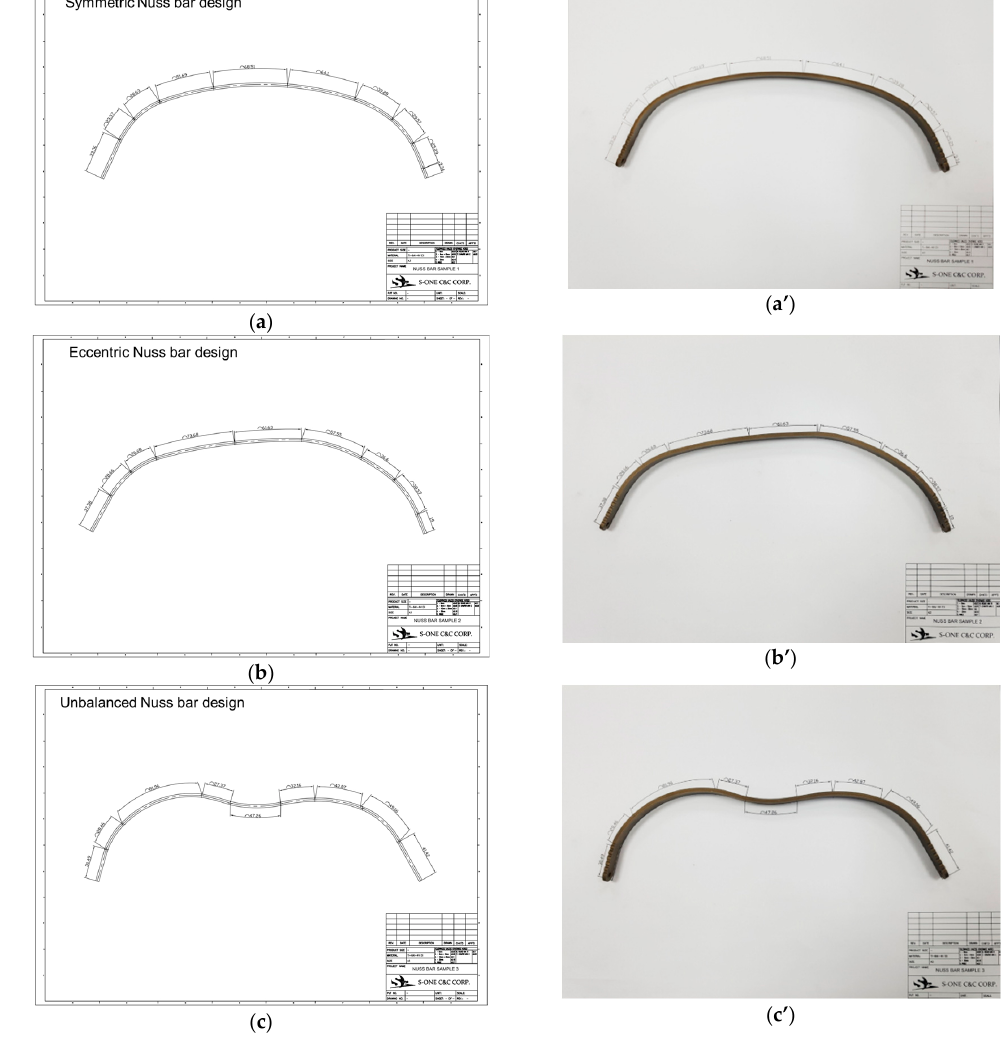
Figure 20. Three types of patient-specific Nuss bar drawings and products with Ti-Gr5: ( a ) symmetric Nuss bar design and ( a’ ) symmetric Nuss bar product for Patient No. 1; ( b ) eccentric Nuss bar design, which was fitted for an asymmetric chest wall patient (Patient No. 2), and ( b’ ) eccentric Nuss bar product; ( c ) unbalanced Nuss bar design, which was fitted for an asymmetric chest wall patient (Patient No. 3), And ( c’ ) unbalanced Nuss bar product.